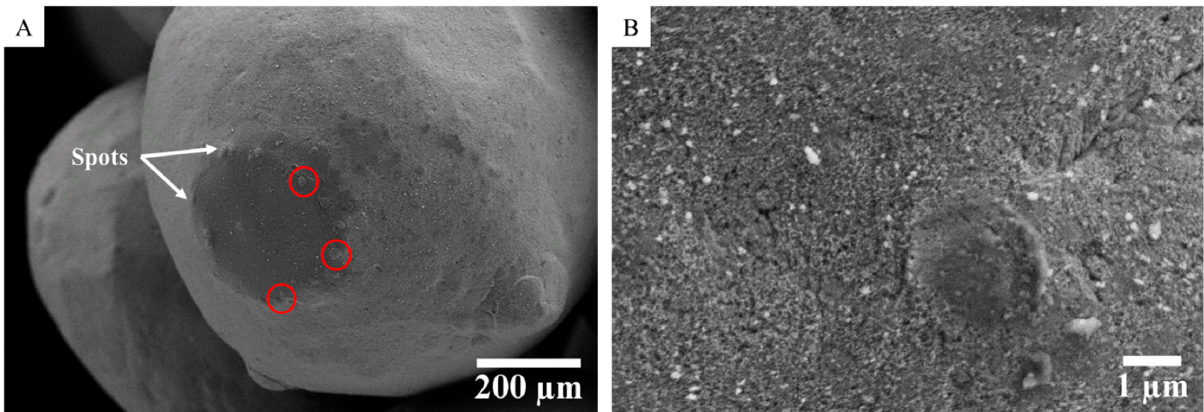
Figure 5. SEM observations of the raw powder after application of a low DC current up to 10 µA ( stage 1 ): ( A ) spots (encircled in red) located along the perimeter of the contact area between two adjacent particles; ( B ) high magnification of these spots.